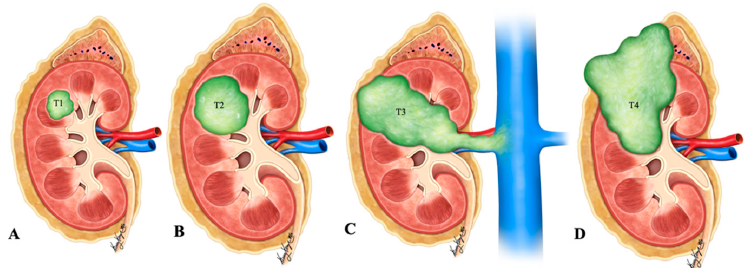
Figure 2. Illustration of renal neuroendocrine carcinoma. ( A ) T1: tumor limited to kidney and ≤ 7 cm in greatest dimension; ( B ) T2: tumor limited to kidney and >7 cm in dimension; ( C ) T3: tumor extending into the major vein or the tissue around the kidney; ( D ) T4: tumor growth beyond the Gerota’s fascia and may be growing into the adrenal